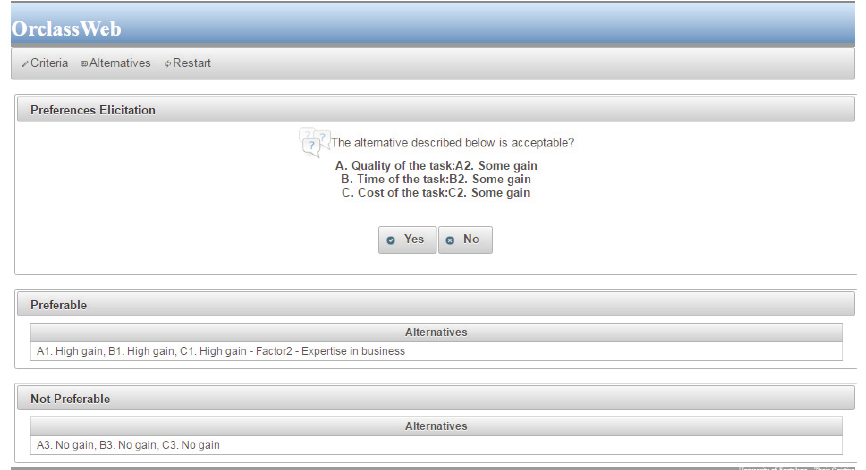
Figure 4: ORCLASSWEB’s interface for construction of the classification rule.